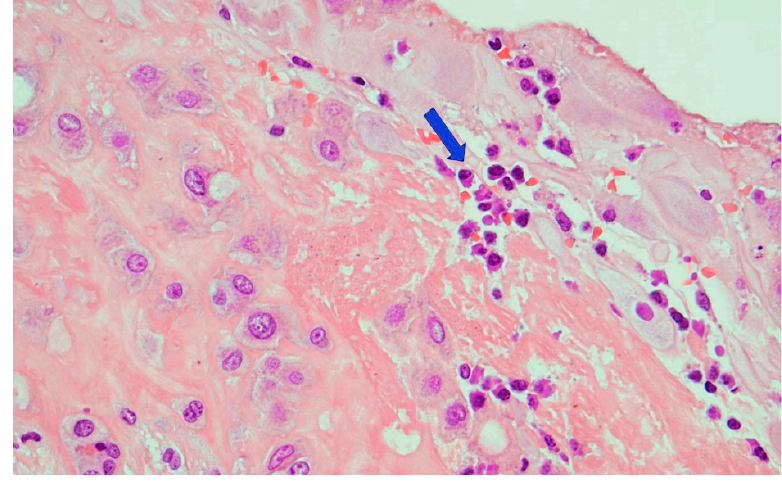
Figure 7. Chronic deciduitis: the decidua showed numerous plasma cells (arrow)(Hematoxylin and Eosin staining, 20 HPF).